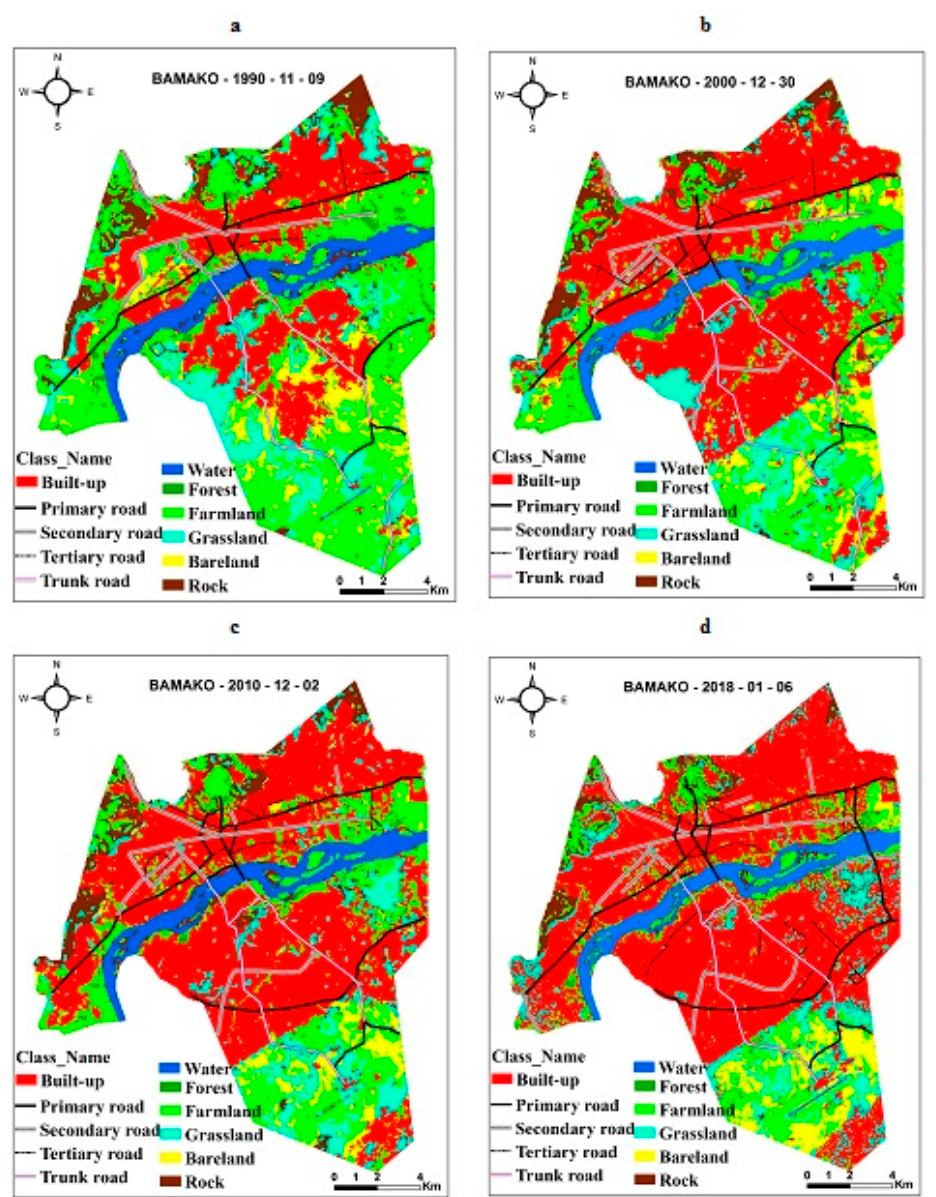
Figure 3. Land cover classification maps in Bamako district from 1990 to 2018. ( a ) land cover map 1990; ( b ) land cover map 2000; ( c ) land cover map: 2010; ( d ) land cover map 2018.